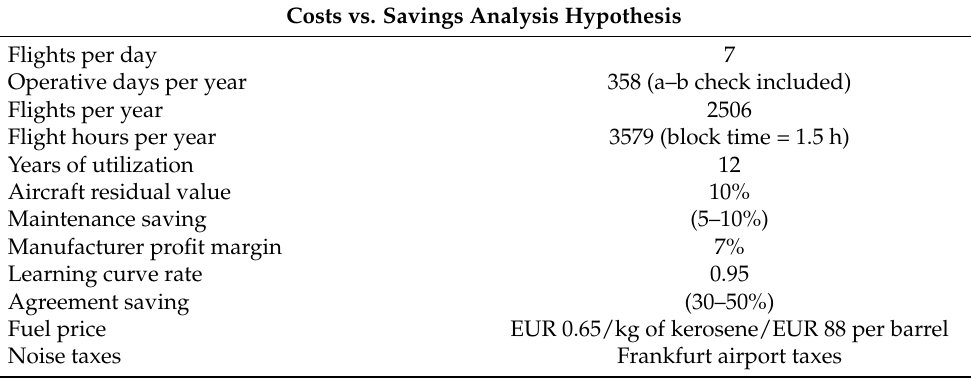
Table 12. The hypothesis that is assumed to compute the costs and savings arising from the multidis- ciplinary retrofitting